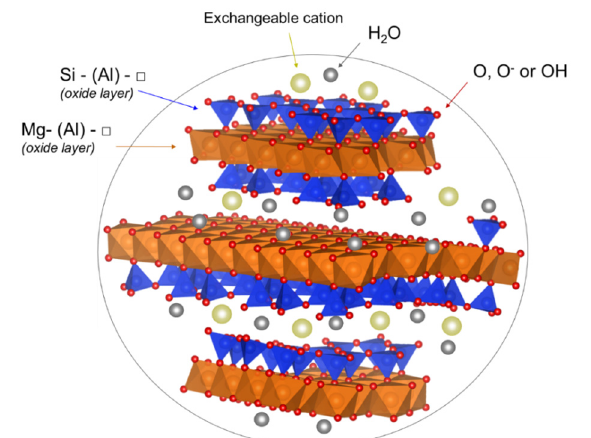
Figure 2. Potential schematic sketch for the structure of M ‐ (A ‐ )S ‐ H based on the structural information from [9, 19, 21, 41 ‐ 43, 46]. Details on the surface of M ‐ S ‐ H is given in Fig. 4.